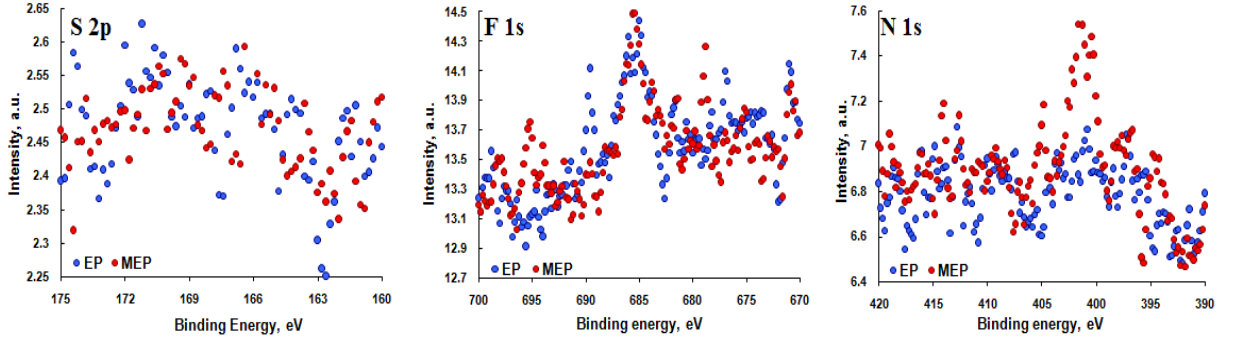
Figure 4. XPS high resolution S 2p, F 1s and N 1s spectra of TNZ alloy sample surfaces after EP and